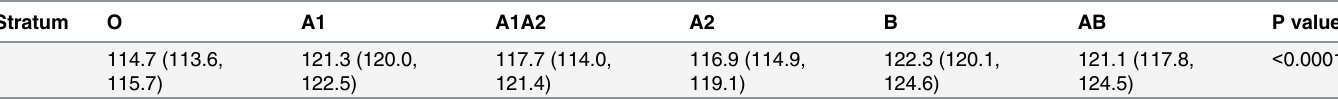
Table 4. Geometric Mean (95% CI) of FVIII Activity (%) in A Blood Groups * . Stratum